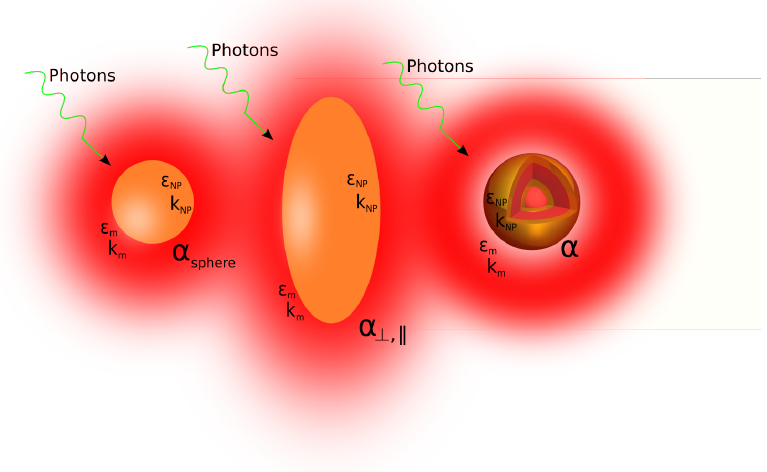
Figure 2. Sphere, ellipse and a complex structure of metal nanoparticles. Temperature variation around the MNP can be described through polarizability α , a parameter that depends on shape, structure and metal that the MNP is made of (dielectric permittivity ε NP and thermal conductivity k NP ) as well as on the surrounding medium (dielectric permittivity ε m and thermal conductivity k m